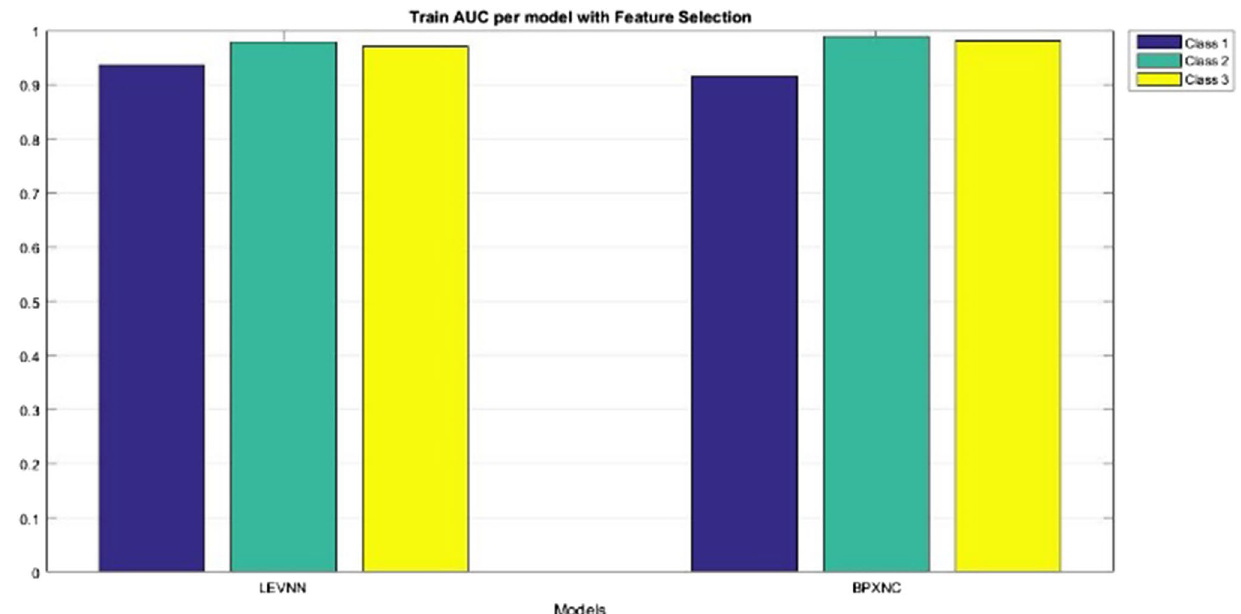
Fig. 11 AUC (training) for LEVNN and